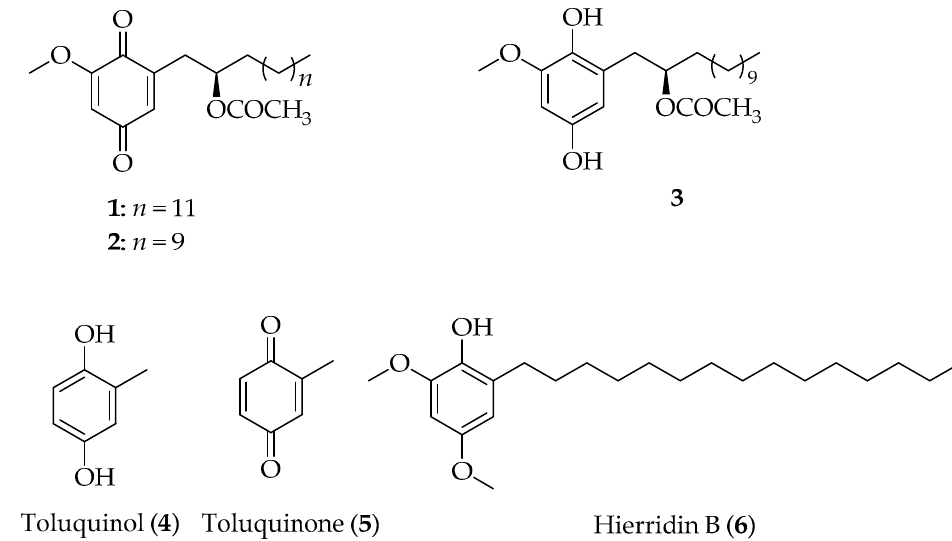
Figure 1. Structure of quinones and hydroquinones with cytotoxic activity.